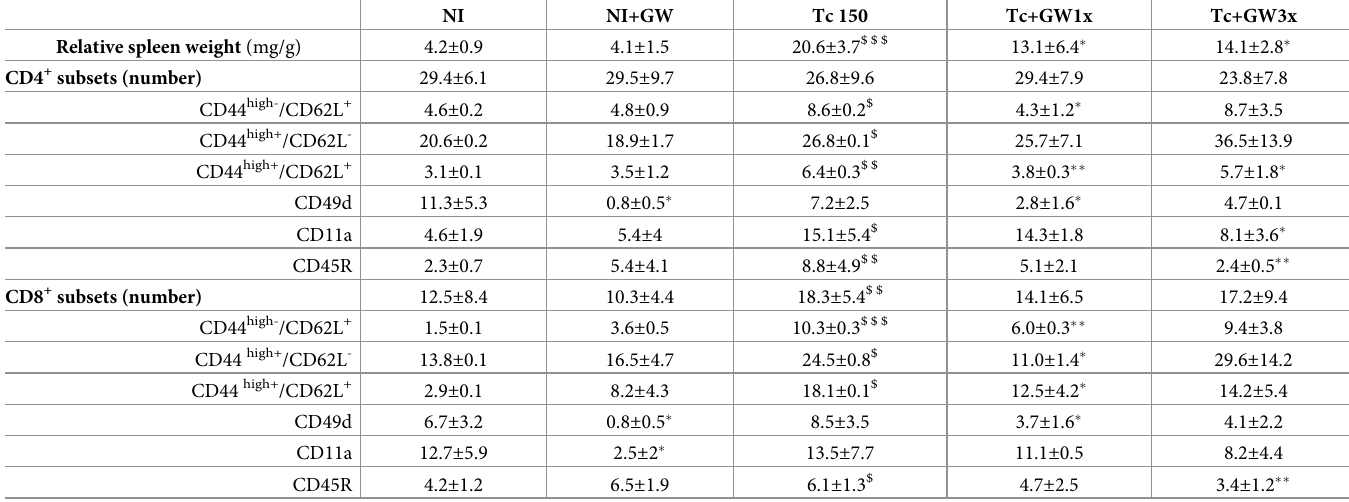
Table 2. Inflammatory